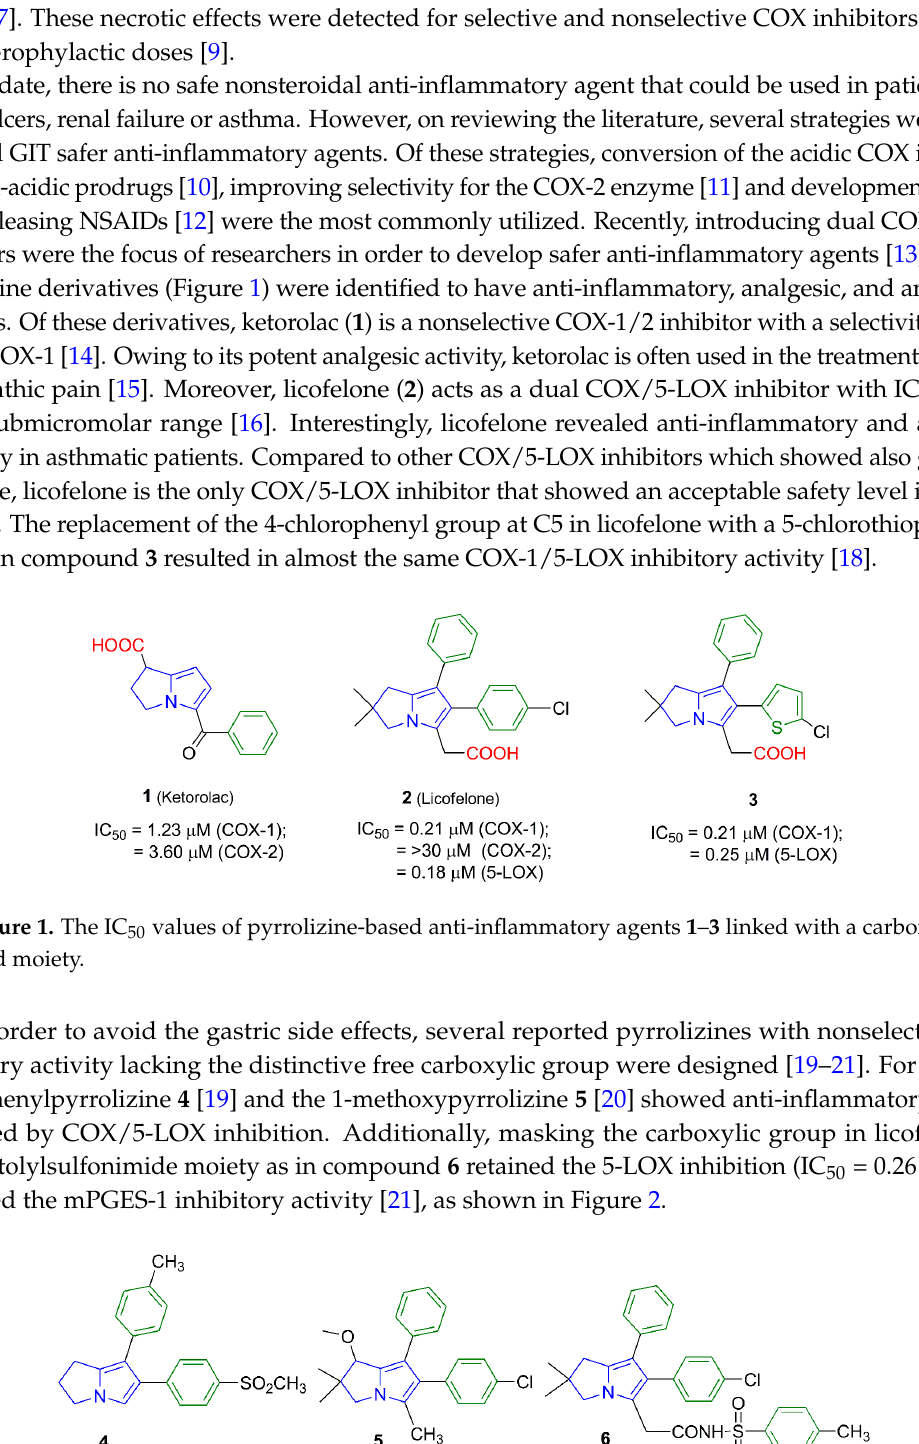
Figure 2. The IC 50 values of pyrrolizine-based anti-inflammatory agents 4 – 6 lacking the free carboxylic acid group.